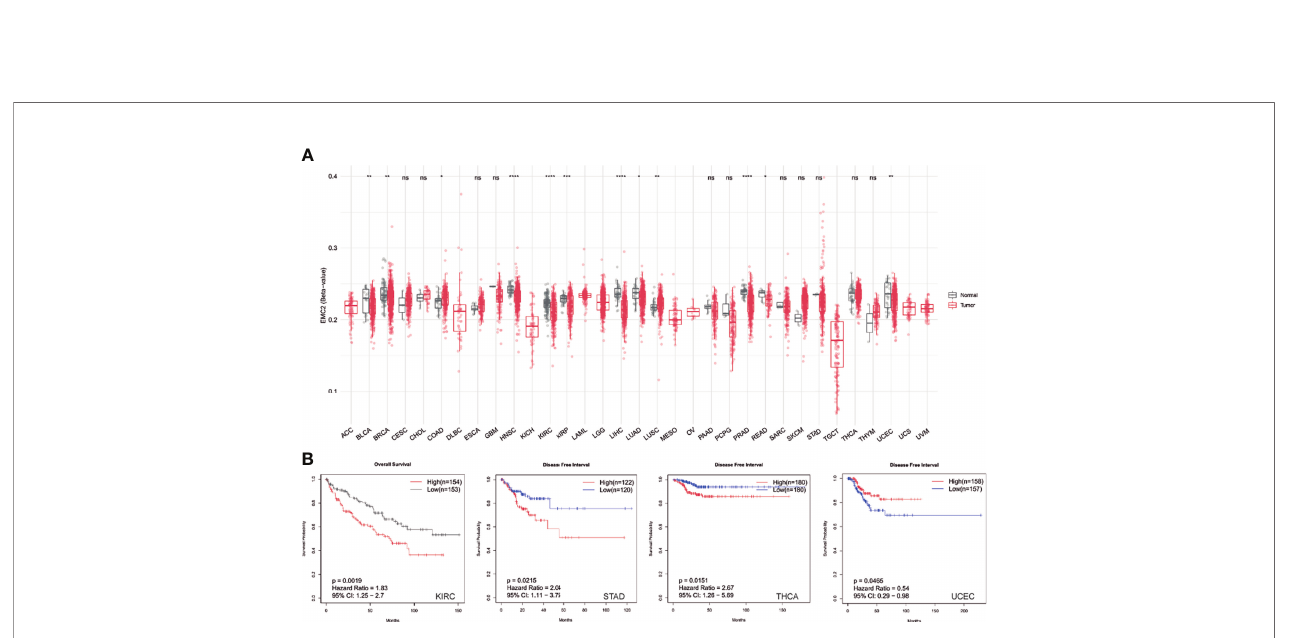
FIGURE 4 | Pan-cancer EMC2 methylation analysis. (A) Pan-cancer differential expression of EMC2. (B) The impact of EMC2 methylation on survival. ns, not signi fi cant; *P < 0.05; **P < 0.01; ***P < 0.001; ****P < 0.0001.